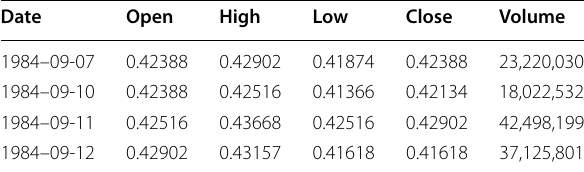
Table 1 Sample input data for apple